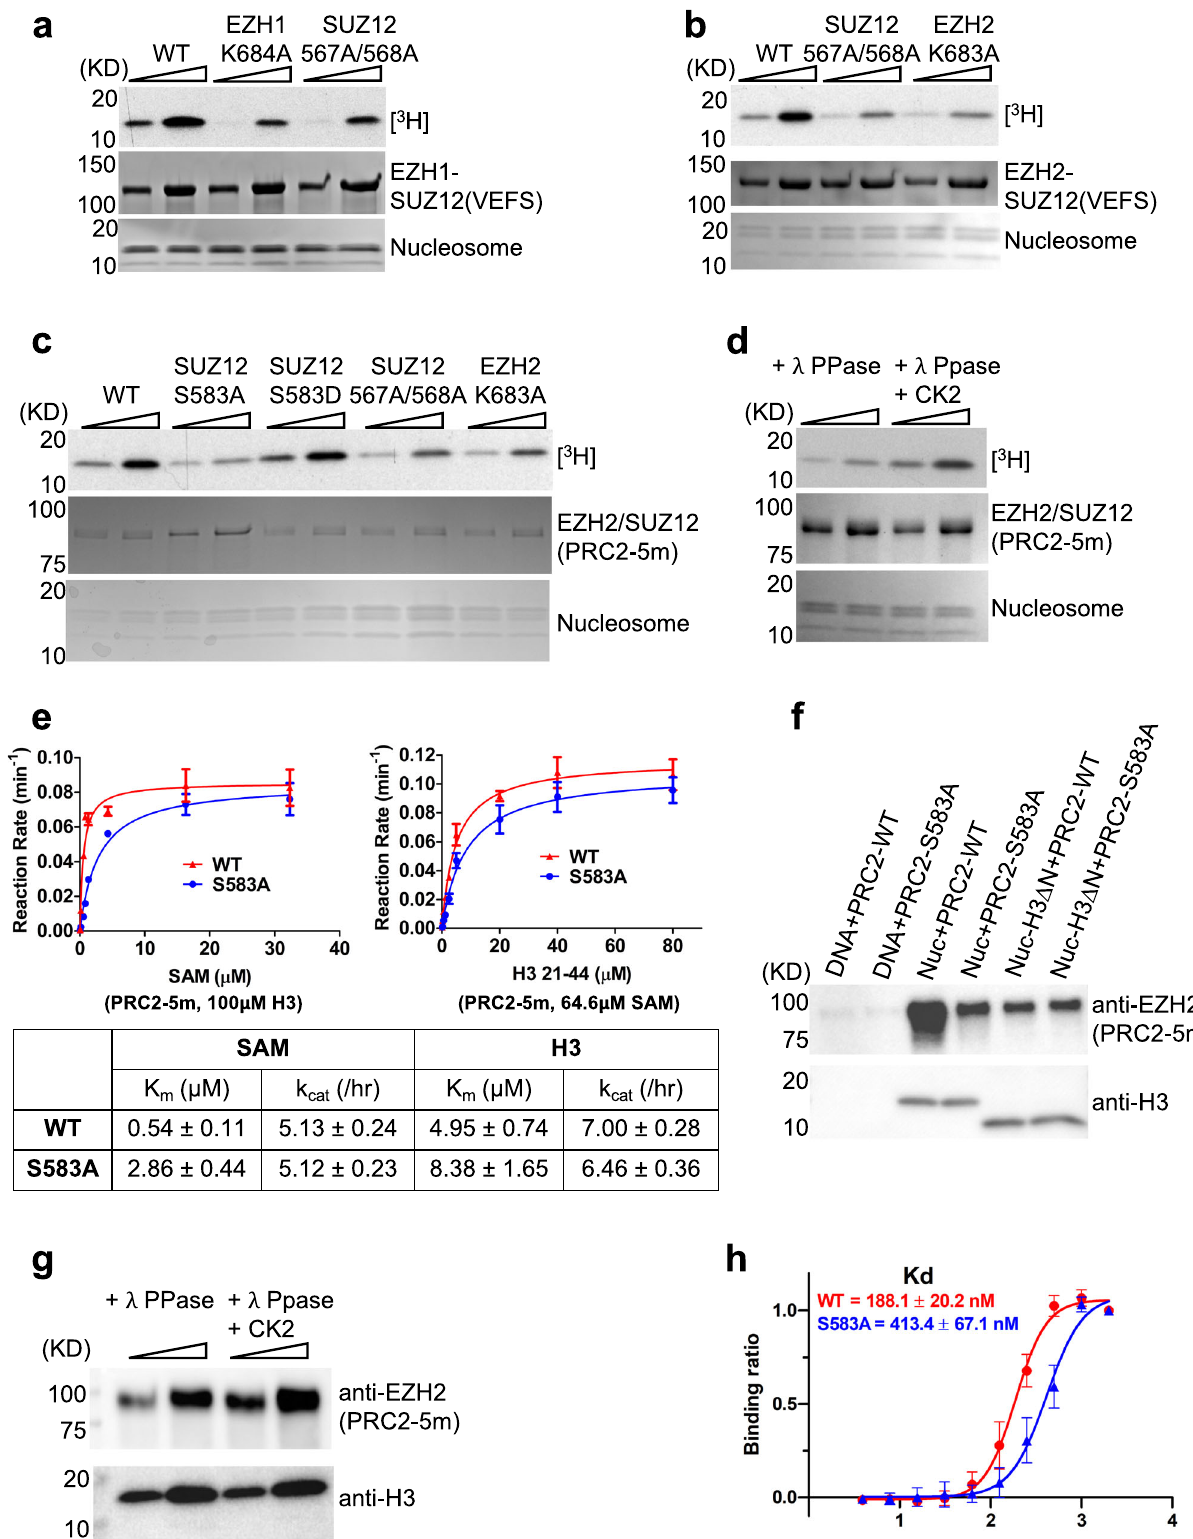
mutant SUZ12 was bound to EZH2 in an anti-EZH2 co-immunopreci- pitation (Co-IP) assay (Fig. 6b), indicating the phosphoserine-centered interactions between SUZ12 and EZH2 are not essential for PRC2 assembly. In addition, PRC2 containing SUZ12 S583A displayed a slightly weaker association with bulk chromatin in mESCs than the WT